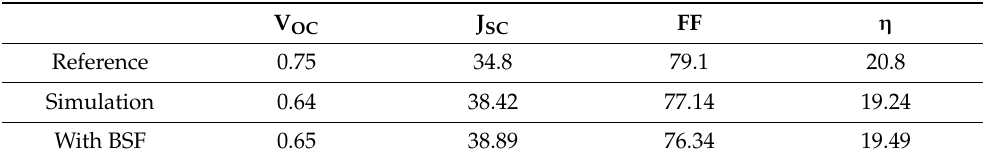
Figure 4. J–V Characteristics of the different structure of the CIGS solar cell. Table 2. Results from simulation compared with experimental data and with solar cell with a BSF